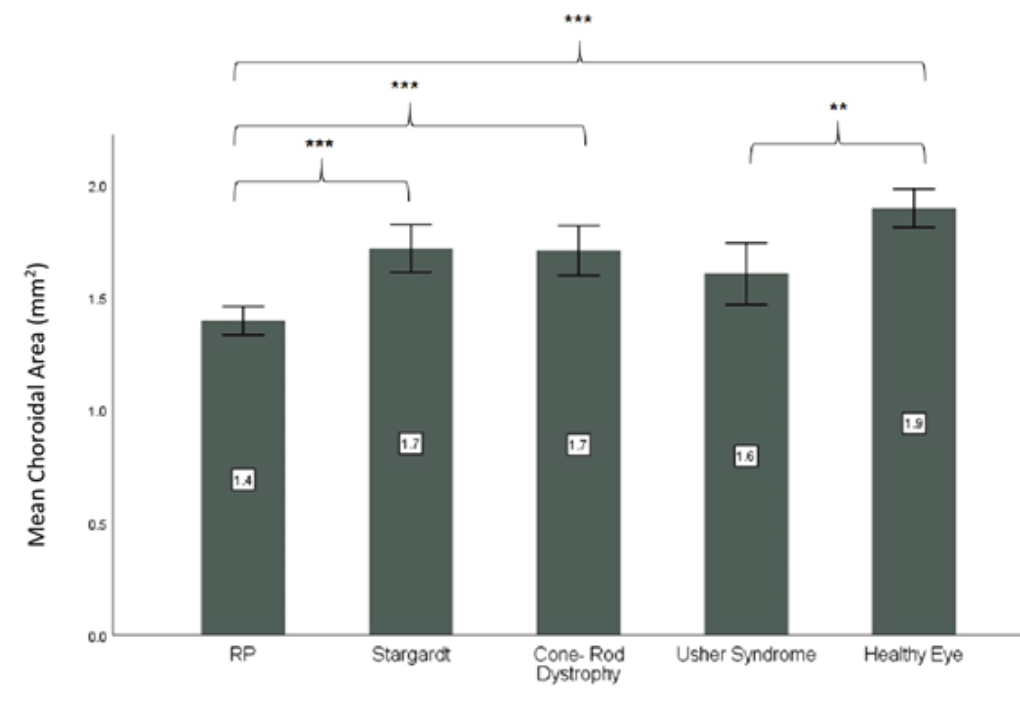
Figure 4. Mean choroidal area in different types of inherited retinal dystrophies RP, retinitis pigmentosa **Significant P -values between 0.01 and 0.001 ***Significant P -values <